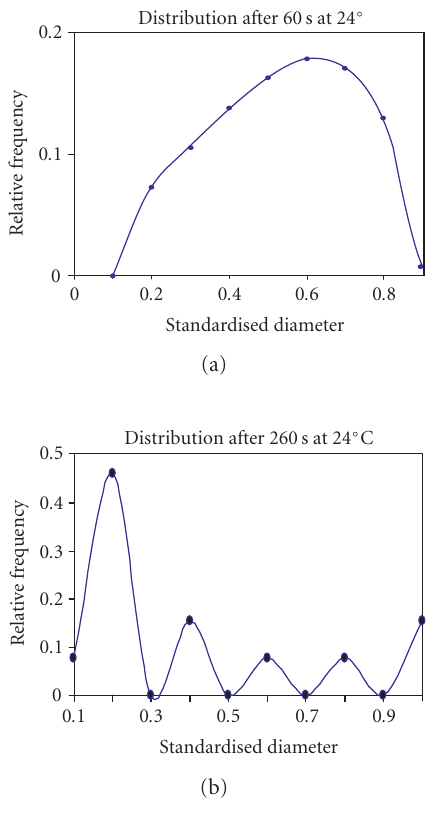
Figure 3.18. Bubble size distribution functions: (a) 60s and (b) 260 s after foaming up at 24 ◦ C; the relative frequency is shown as a function of the bubble size